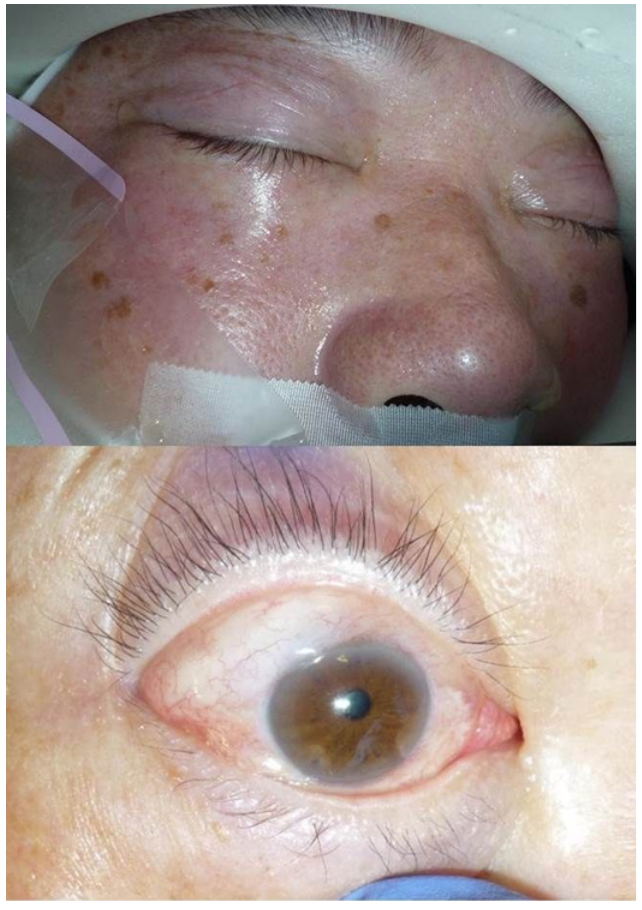
Fig 3. Typical appearance of the periocular swelling and chemosis. Moderate chemosis, lid swelling, and subcutaneous bleeding were observed dominantly in the superior part or the periocular tissues. (10 min after release of the head-down